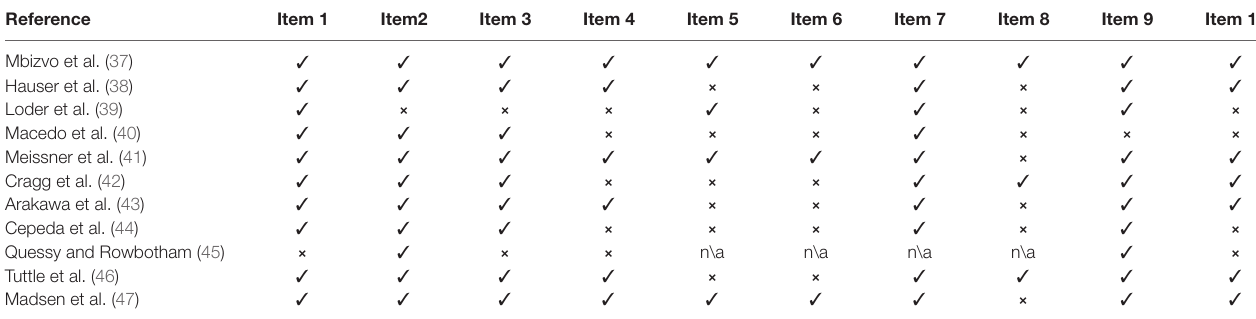
TaBle 3 | Quality assessment of the included reviews.